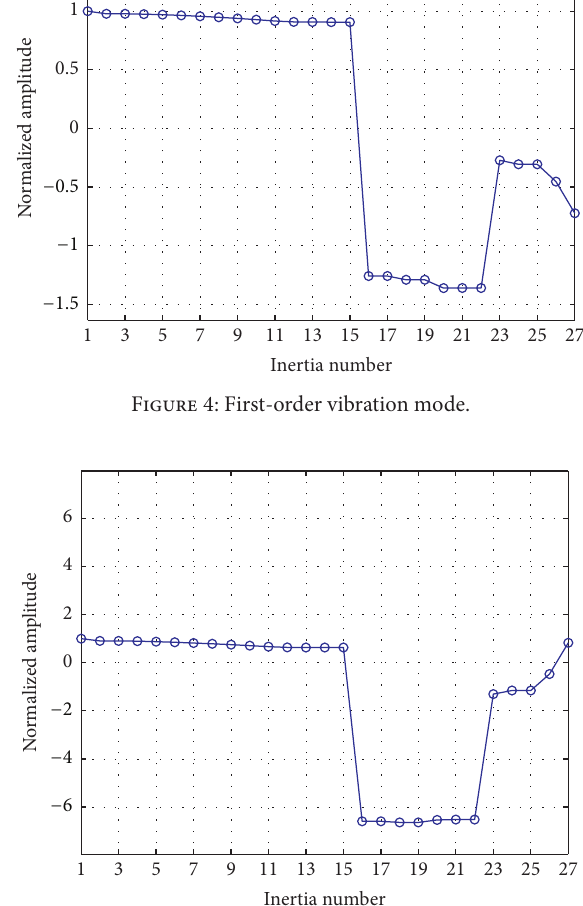
Figure 5: Second-order vibration